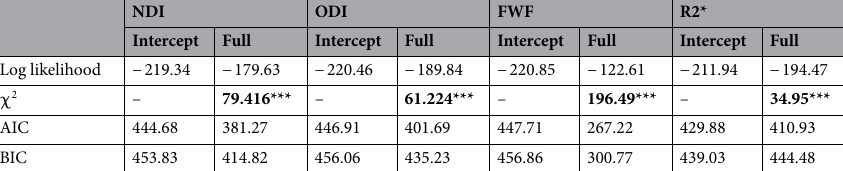
Table 2. Likelihood ratio test results comparing the linear mixed effect models comprised of the intercept of the fixed and random effects (Intercept), and the full model (Full) testing microstructural differences in hypothalamic subunits with age (neurite density index (NDI), orientation dispersion index (ODI), free water fraction (FWF), effective transverse relaxation rate (R2*); Akaike information criterion (AIC), Bayesian information criterion (BIC)). *** p < .001. Significant values are in [bold].